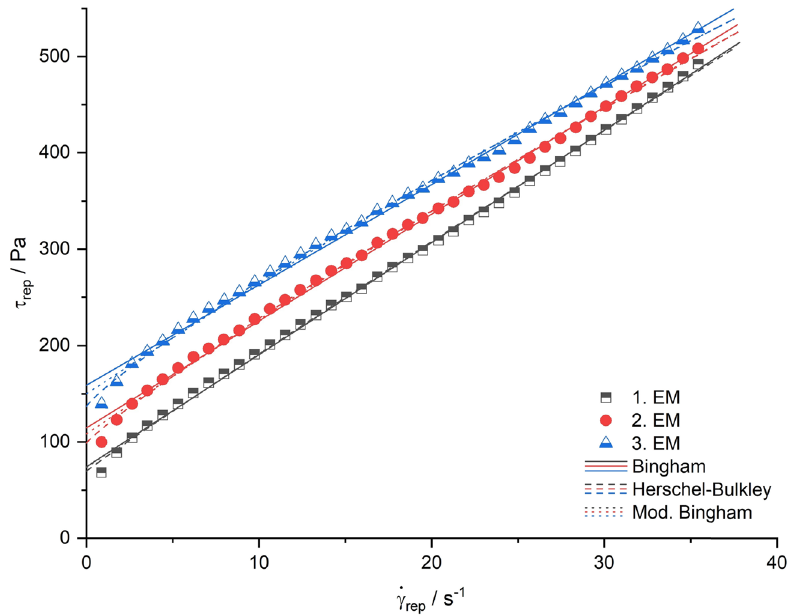
Figure 8: Mean values of the individual measurements of SCC from the fi rst two measurement series fi tted with the Bingham model, the Herschel – Bulkley model, and the modi fi ed Bingham